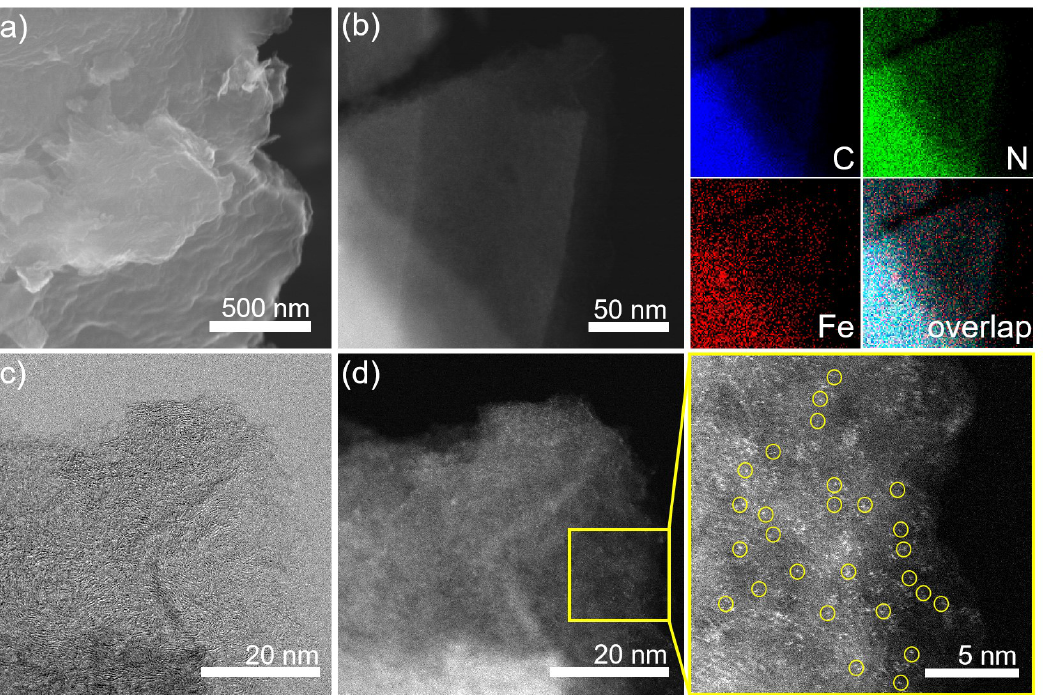
Figure 3. Microscopic characterization of the SA-Fe@NC 800 . ( a ) SEM image, ( b ) HAADF-STEM image and elemental mapping, C (blue), N (green) Fe (red) and overlay. ( c ) ABF image, ( d ) HAADF-STEM image and the enlarged view.